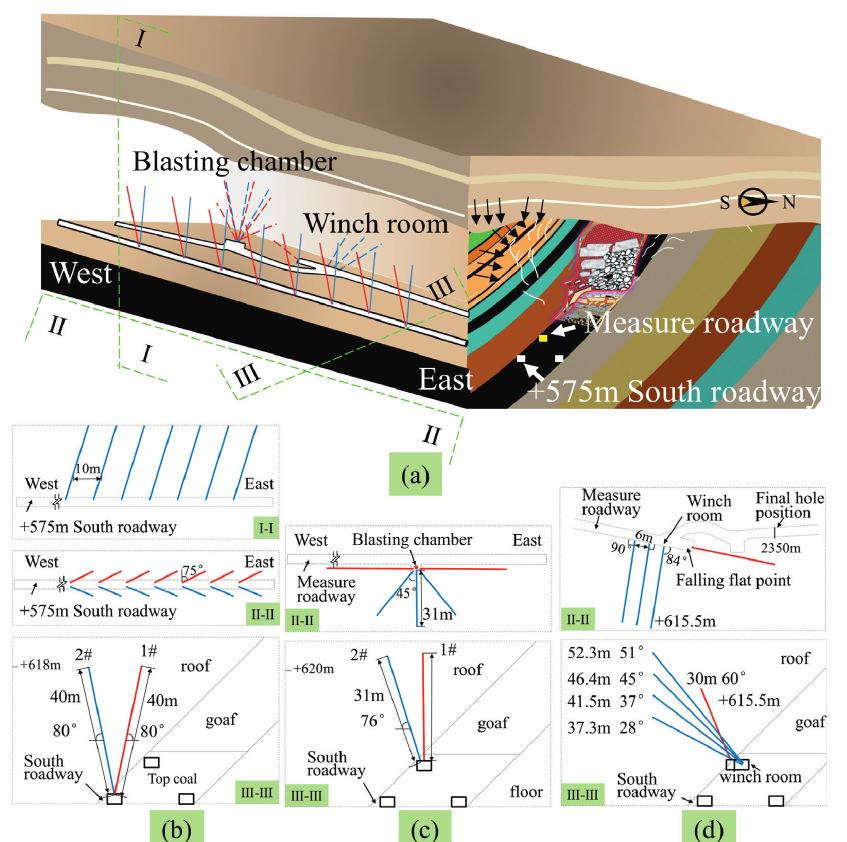
Figure 11: Blast hole layout of precracking suspended roof. (a) Stereogram of blasthole arrangement; (b) layout of blasting holes in south roadway; (c) layout of blasting holes in blasting chamber; (d) layout of blasting holes in winch